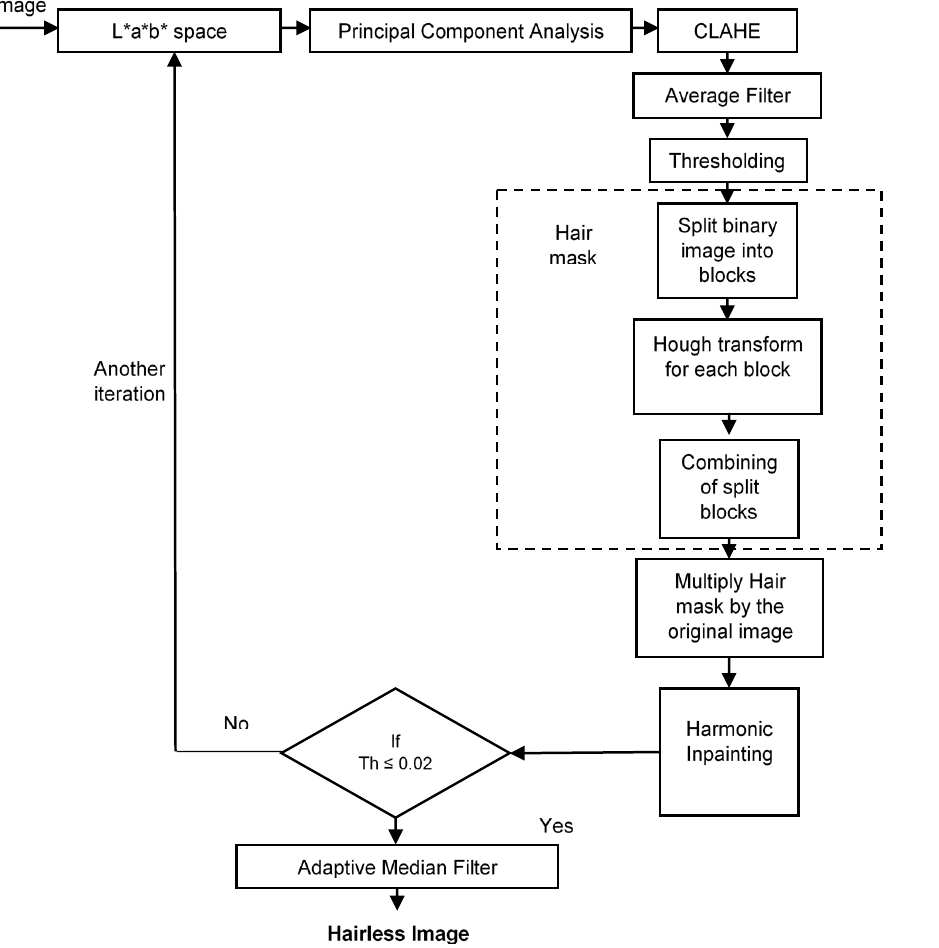
Figure 1. Proposed hair removal technique.